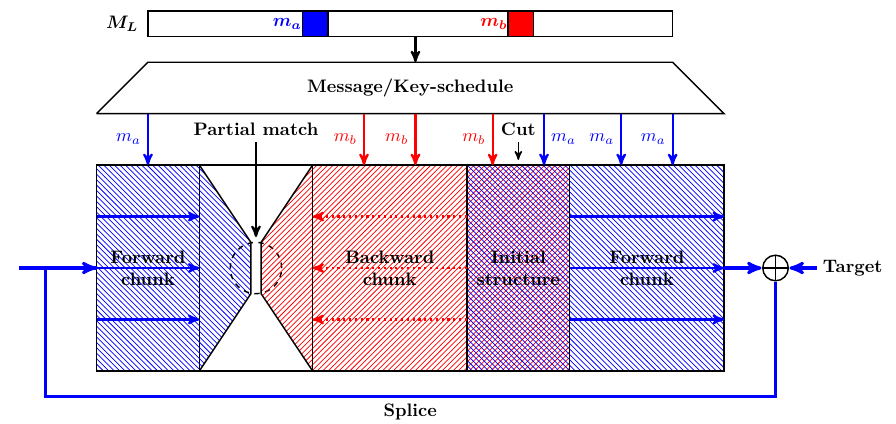
Figure 4: The advanced MITM pseudo-preimage attack on DM-mode